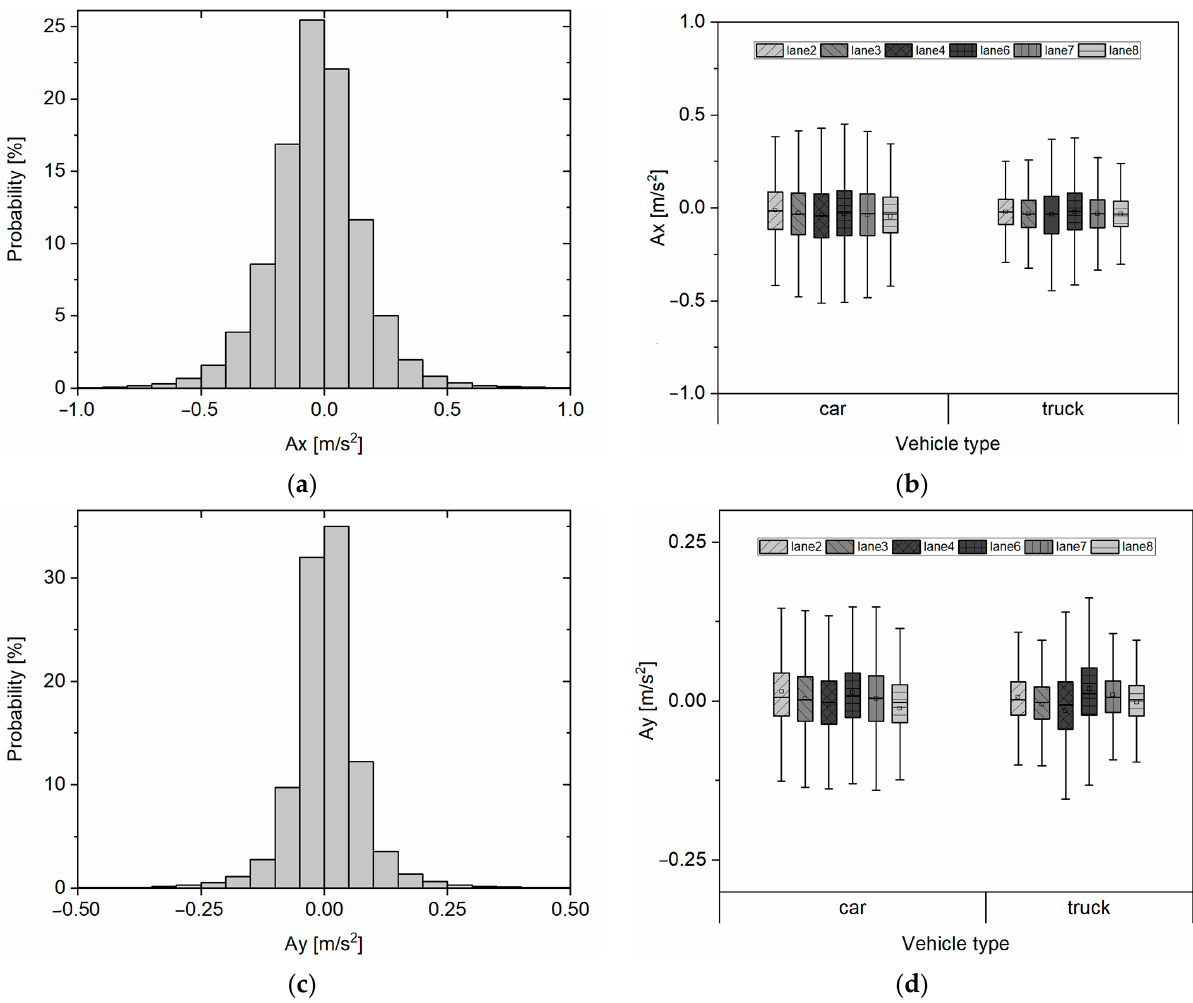
Figure 10. Probability distribution of longitudinal ( a ) and lateral ( b ) acceleration; Longitudinal ( c ) and lateral ( d ) acceleration for car and truck in different lanes.